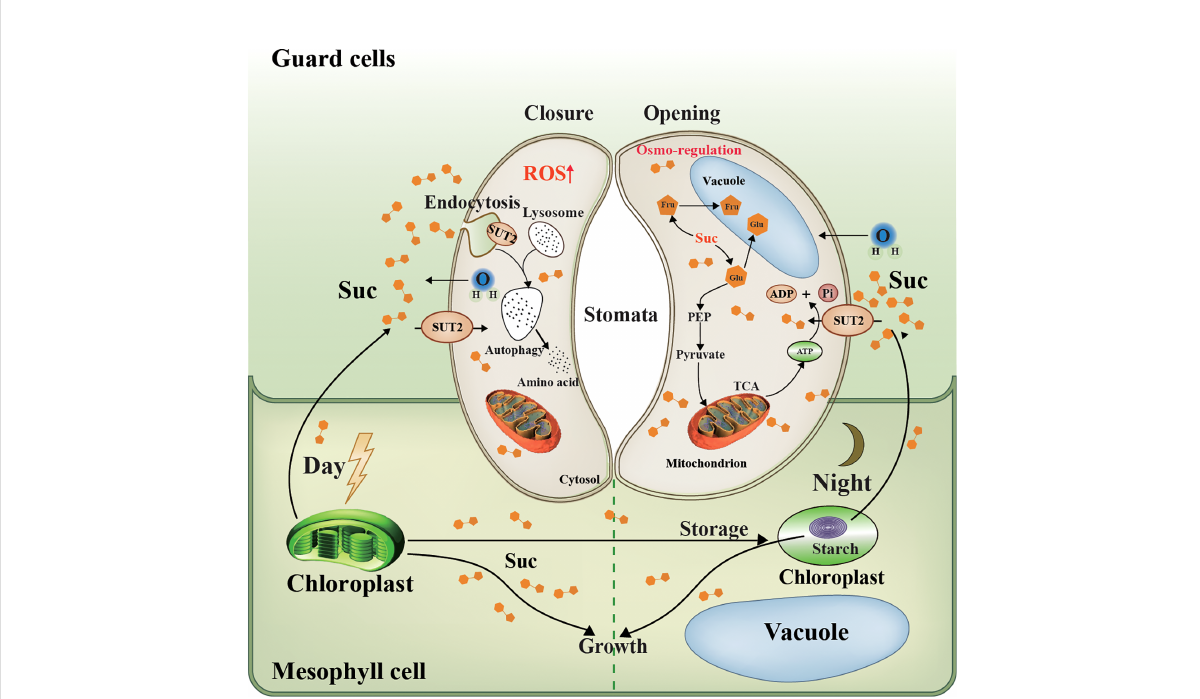
FIGURE 9 Schematic representation of LpSUT2 local endocytosis in guard cells. Photosynthesis in mesophyll cells is the main source of sucrose for the whole plant (Flütsch et al., 2020). In the daytime, fi xed CO 2 , in the form of soluble sugar, is either stored in the chloroplast as transient starch or exported as sucrose to heterotrophic tissues such as root and guard cells (MacNeill et al., 2017). Our work showed that LpSUT2:eGFP protein was polarly distributed in duckweed guard cells: it is only located on the endomembrane of guard cells in the mature fronds of duckweed, while symmetrical distributed on that of young fronds. This might result from the up-regulation of LpSUT2 expression that led to hyperosmotic stress in guard cells, and then triggered the production of the signal molecule ROS, subsequently activated local endocytosis of LpSUT2 in guard cells. The change of stomatal behavior further suggests that the local endocytosis LpSUT2 occurred. Sucrose in guard cells can be broken down into hexose and stored in vacuoles (glucose and fructose), or can be produced into pyruvate through glycolysis, which enters the mitochondria to produce ATP through the TCA cycle. The opening of the stomata consumes energy, the ATP produced from the TCA cycle mentioned above. LpSUT2, sucrose transporter of L. punctata ; Suc, sucrose; CO 2 , carbon dioxide; eGFP, Enhanced green fl uorescent protein; Glu, Glucose; Fru, fructose; Mal, malate; ATP, Adenosine triphosphate; ADP, adenosine diphosphate; TCA, tricarboxylic acid cycle; PEP,